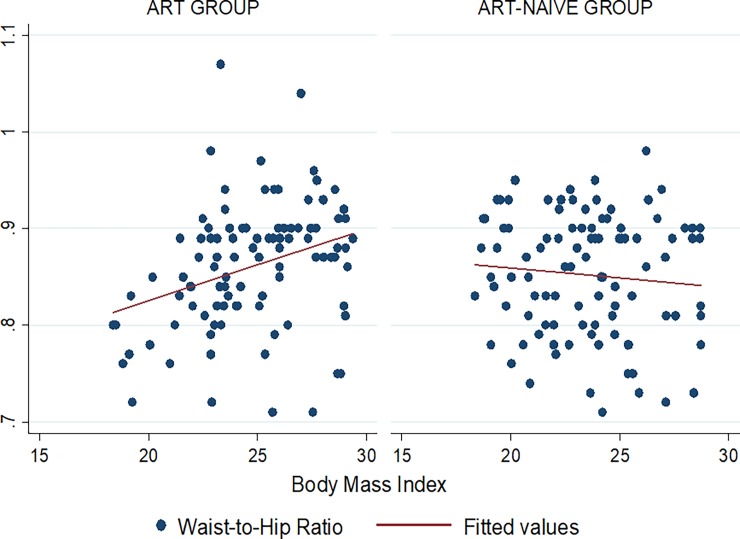
Linear regression model of the association between WHR and BMI according to HAART status.